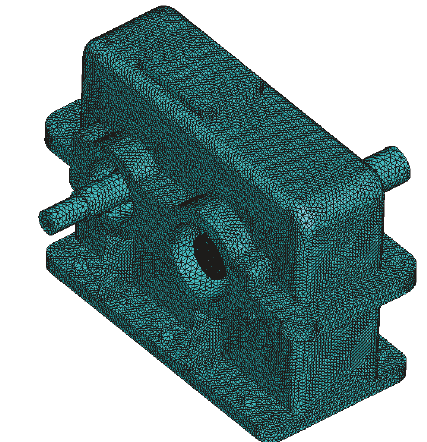
Figure 9: Finite element model of the coupled model.